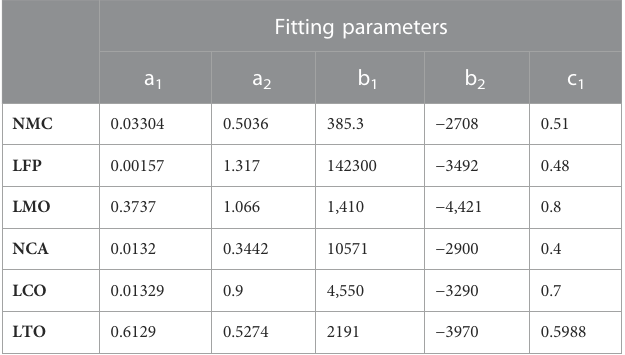
TABLE 3 Fitting parameter values for all six LIB